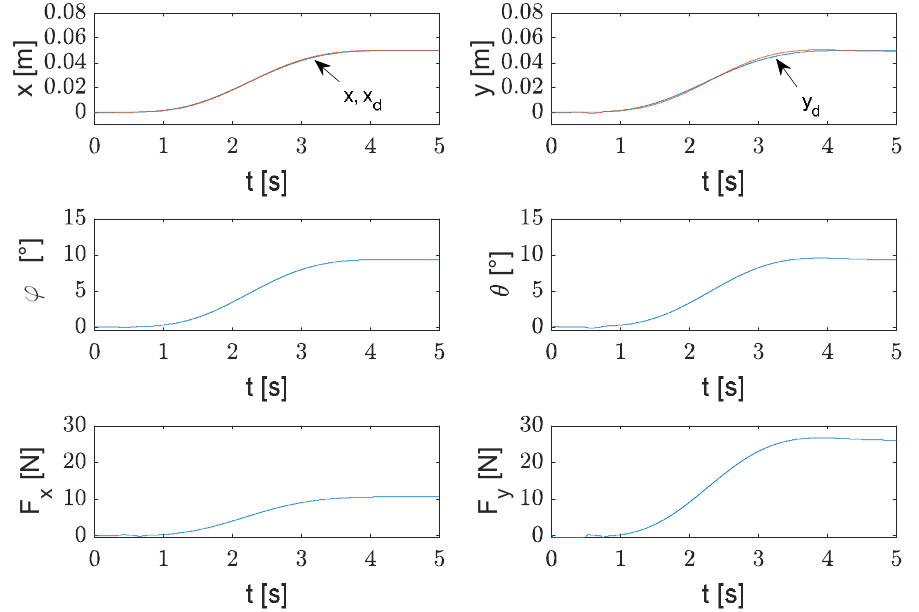
Figure 27. Response for a combined movement of dorsiflexion and abduction, with disturbance.